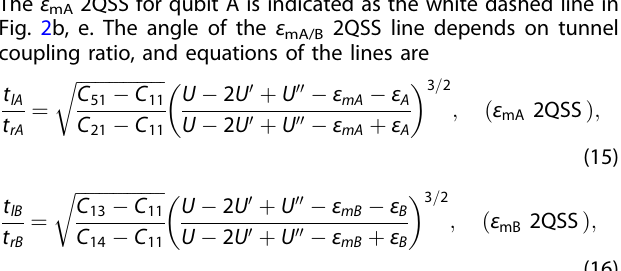
ffiffiffiffiffiffiffiffiffiffiffiffiffiffiffiffiffiffiffi C 13 (cid:3) C 11